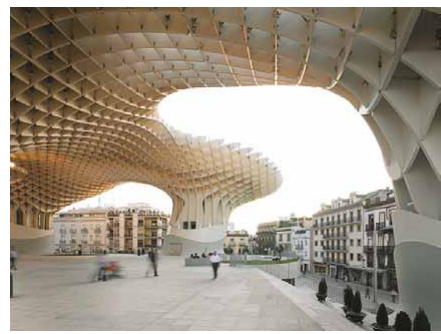
Fig. 34. Competition project of the tree path, first place, view of the tower, archit.